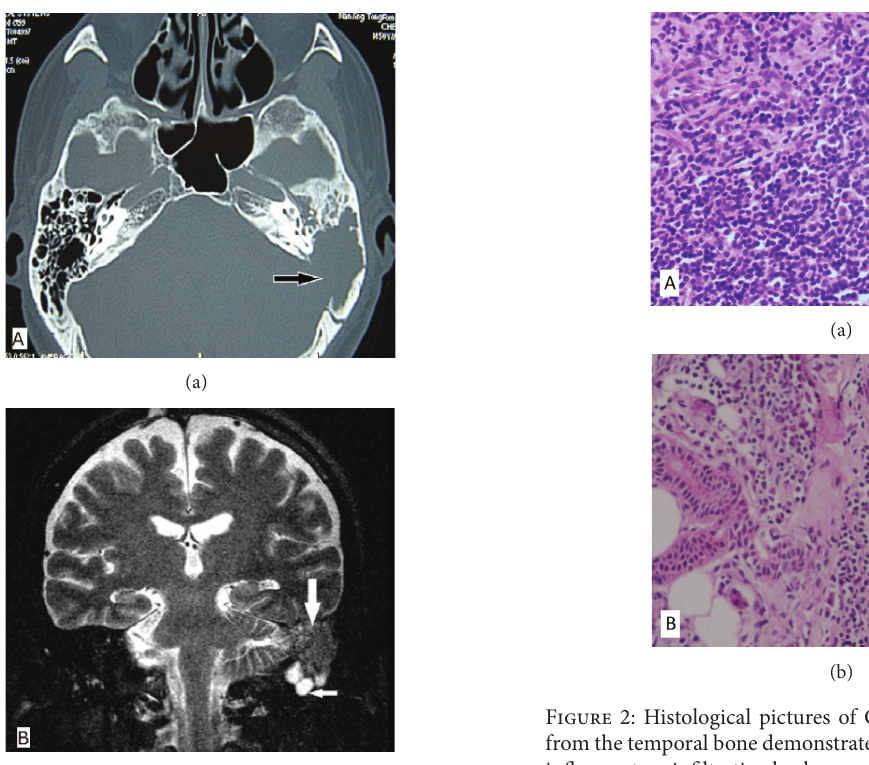
lymph nodes are seen (small arrow).